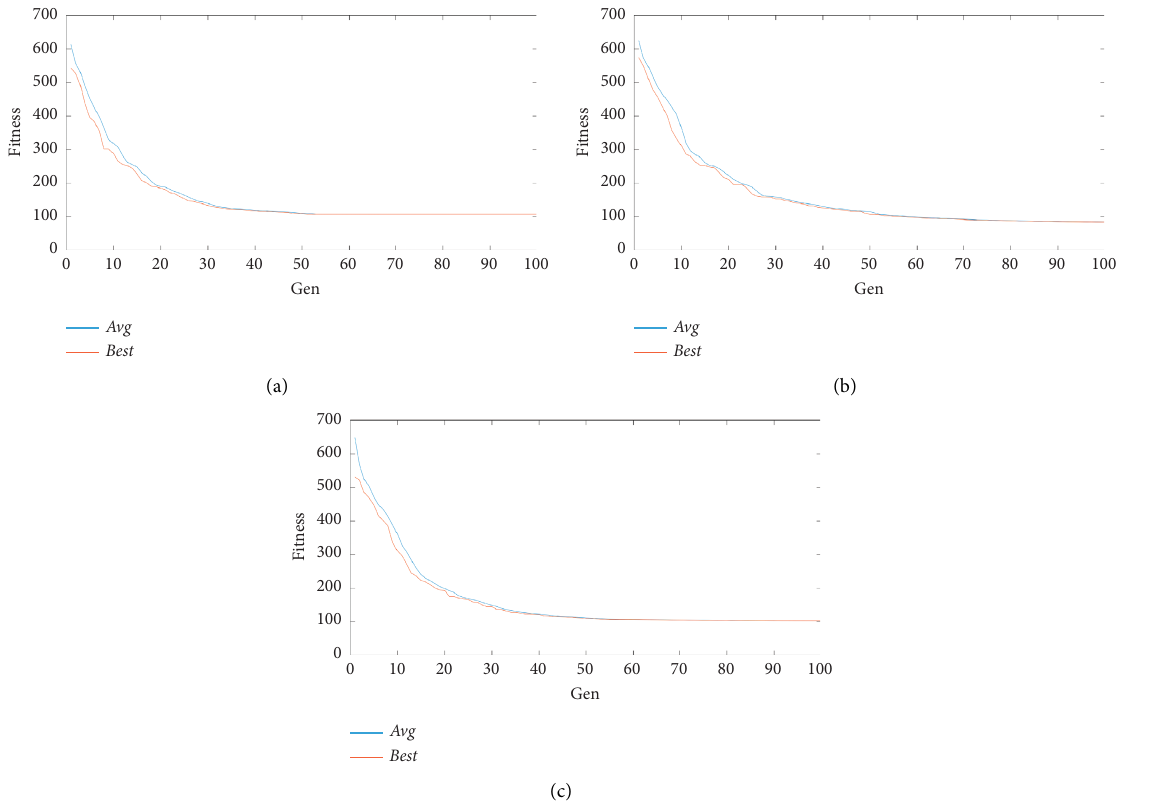
Figure 6: The fitness change of three different schemes. (a) Scheme 1 is to randomly extract the maximum and minimum features of the trajectory. (b) Scheme 2 takes random extraction of maximum and minimum features as the main method and random extraction of features as the secondary method. (c) Scheme 3 is to randomly extract trajectory